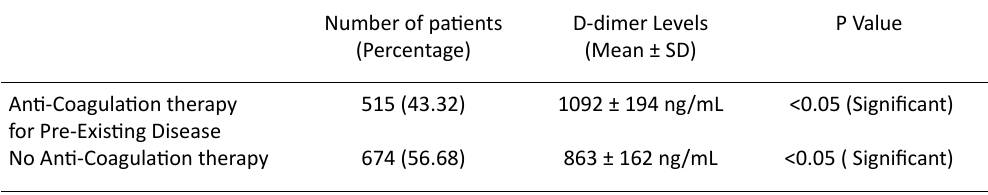
Table 5. Hospitalization and D-dimer